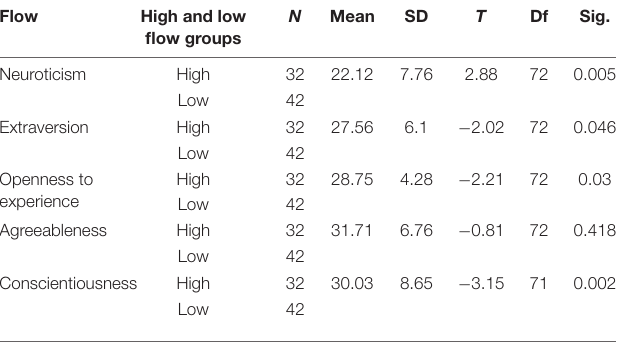
TABLE 4 | The difference between the means of high flow (autotelic) and low flow (non-autotelic) teachers for EQ-i subscales. Flow